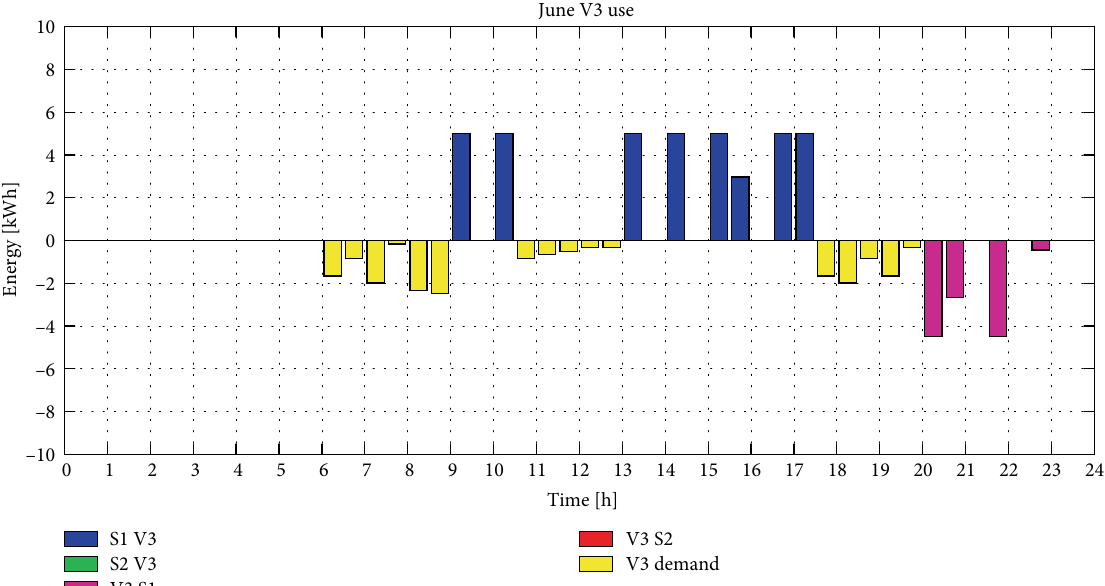
Figure 7: June day electrical profiles for Case 4.2.